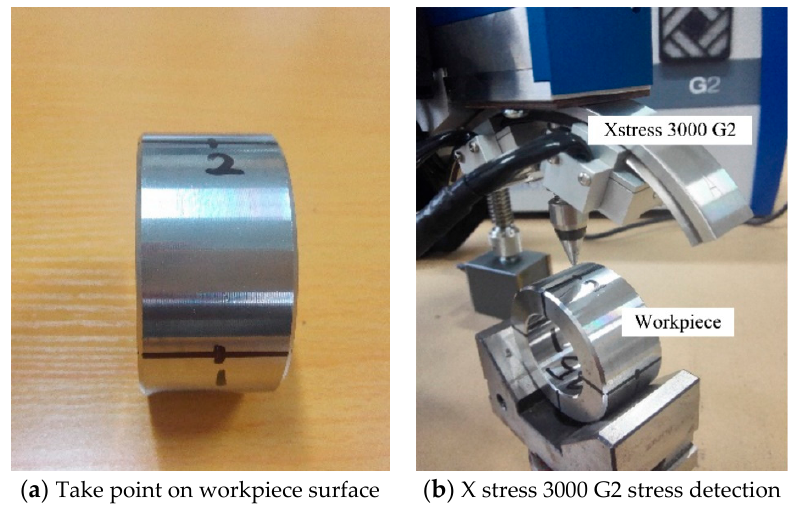
Materials 2019 , 12 , x FOR PEER REVIEW Figure 4. Residual stress testing equipment and testing process. Figure 4. Residual stress testing equipment and testing process.